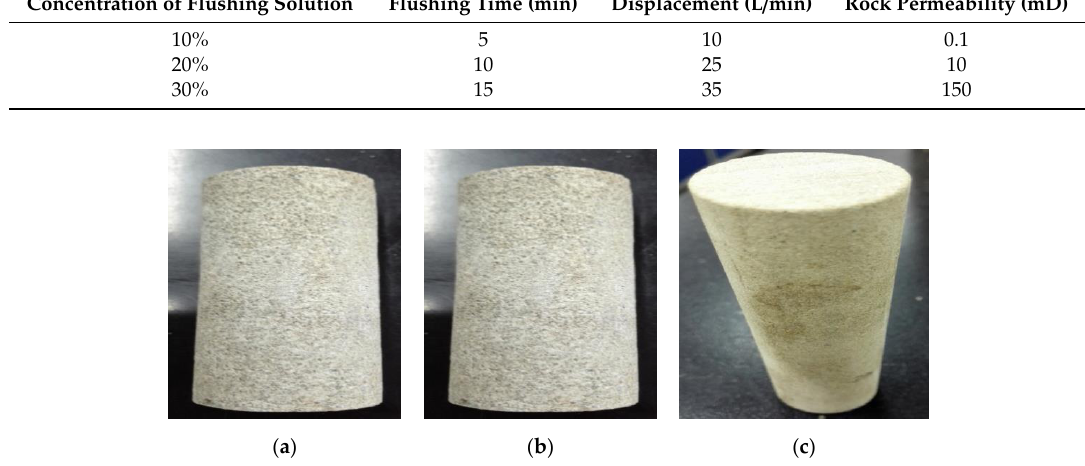
Figure 6. Washing test sample diagram- ( a ) is ultra-low permeability core 0.1mD, ( b ) is medium